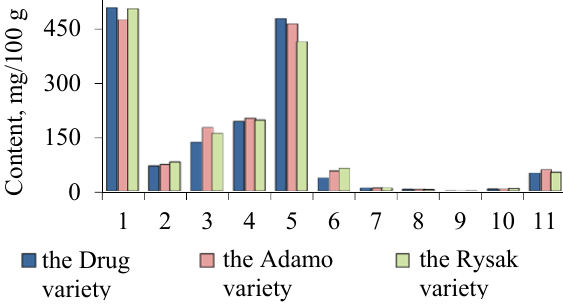
Fig. 2. Analysis of the mineral composition of common oat grains: (1) potassium, (2) calcium, (3) magnesium, (4) sulfur, (5) phosphorus, (6) chlorine, (7) iron, (8) manganese, (9) copper, (10) zinc, (11)